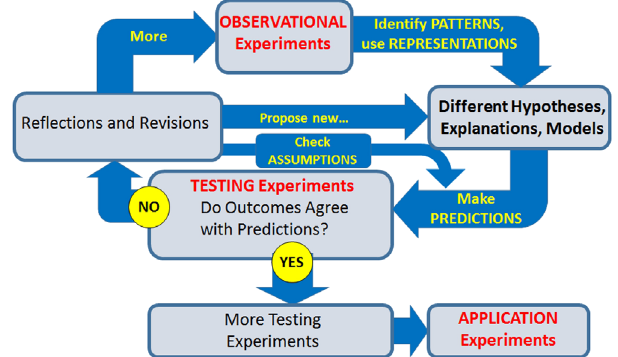
FIG. 6. The underlying epistemic process of ISLE. The process starts on the top of the diagram by students observing